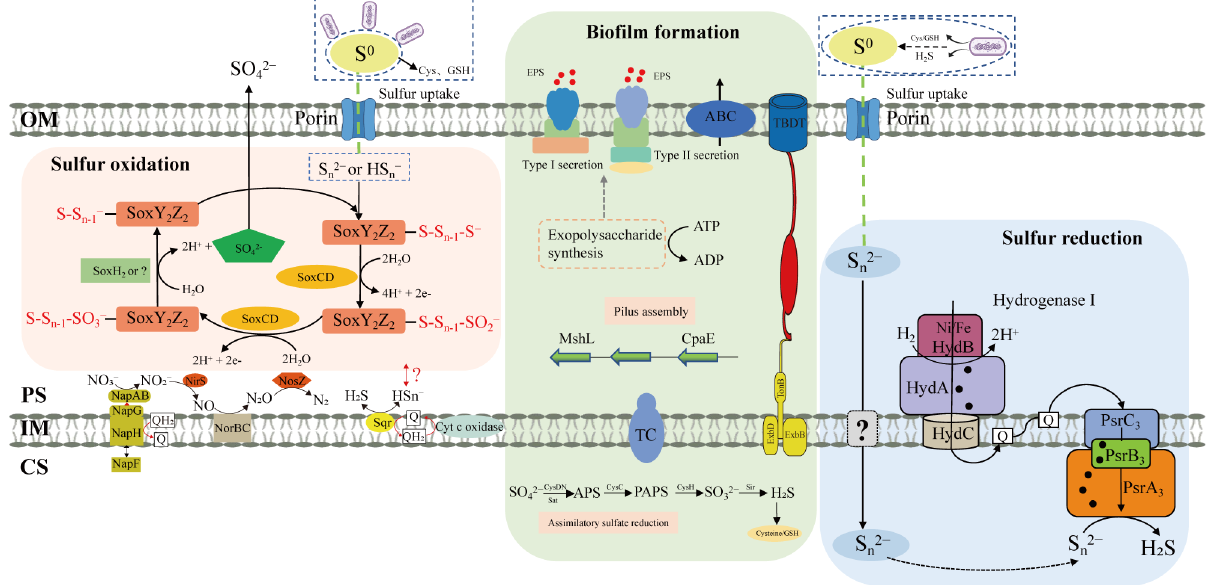
Figure 8. Proposed model for extracellular S 0 activation, transportation and intracellular oxidation and reduction in strain ST-419. OM, outer membrane; PS, periplasmic space; IM, inner membrane; CS, cytoplasmic space; Sox, sulfur-oxidation-multienzyme complex; Q, quinone molecules; Psr, polysulfide reductase; TC, two-component system; TBDT, TonB-dependent transporters. Hypothetical reactions concerning energy conservation are indicated by a question mark.